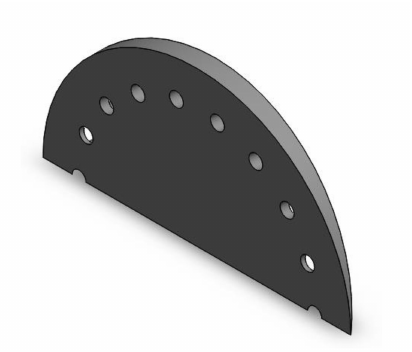
Figure 4. Rearfoot wedge seen from the top in a raised plane.